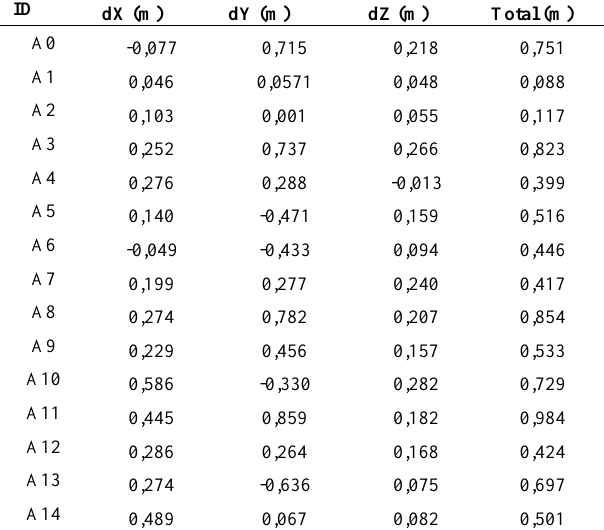
Table 5. Point cloud position deviation value statistic to